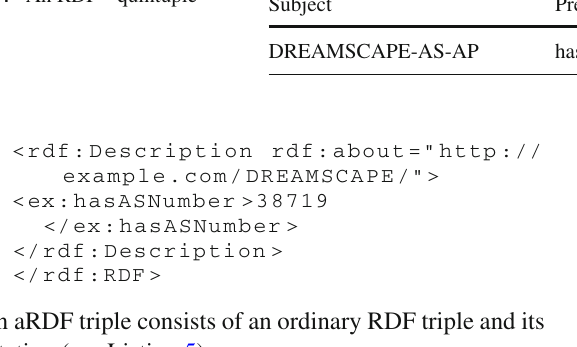
Table 1 An RDF + quintuple Subject Predicate Object Meta-property Meta-value DREAMSCAPE-AS-AP hasASNumber 38719 accordingTo